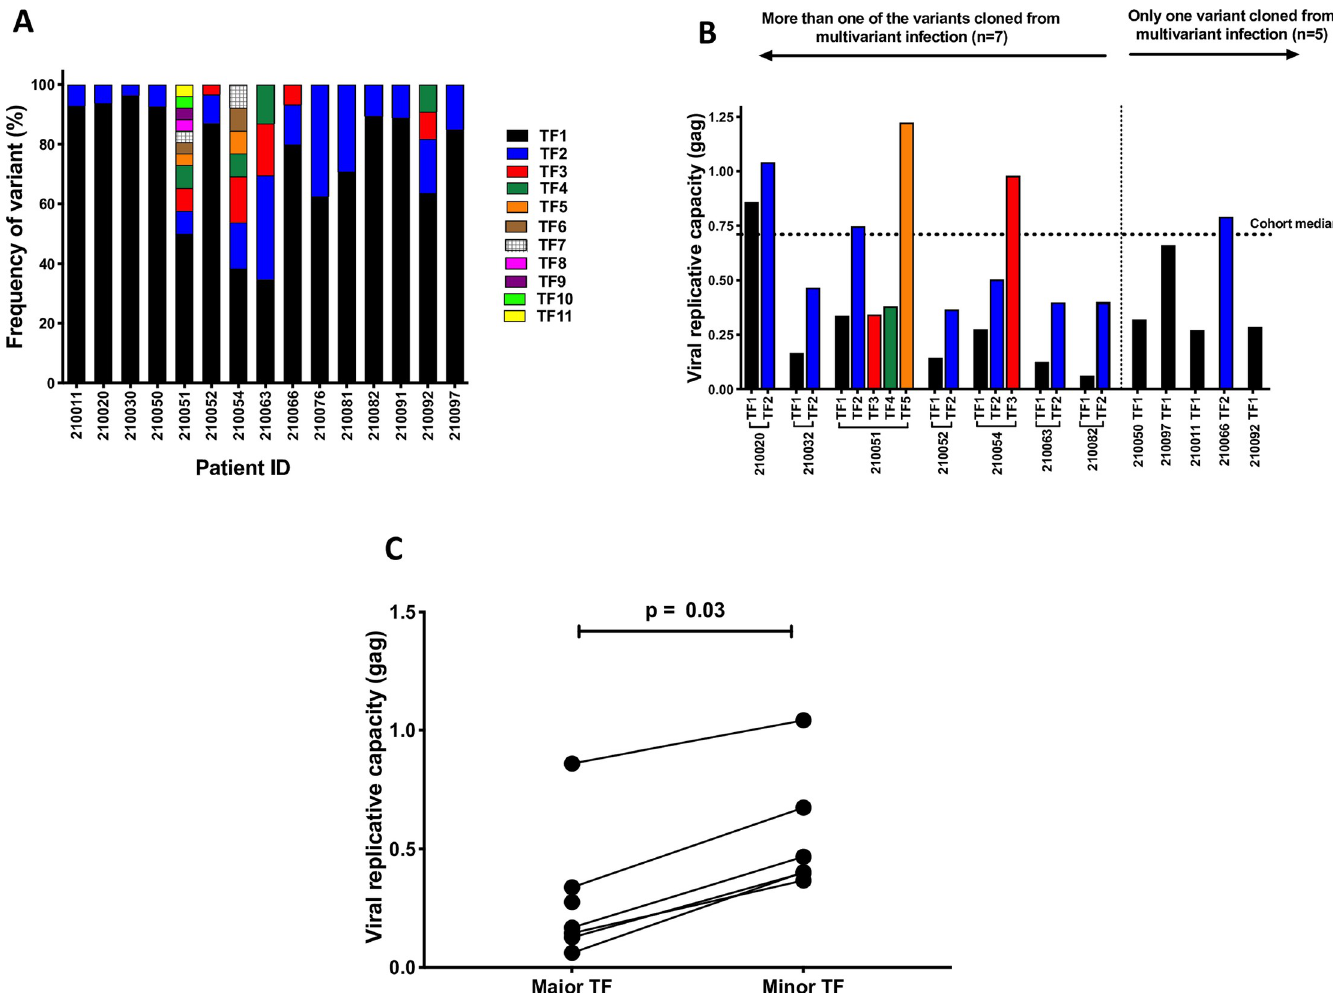
Fig 3. A) Proportion representation of multiple transmitted/founder viruses showing unequal representation of variants, with major variants representing as much as 96% of the virus populations and minor variants representing as low as 3% of the virus population sampled. B) A wide range of replicative capacity of intra patient founder viruses was observed, with no evidence for selection of similar replicative capacity. More than one TF gag variant was cloned and tested in 7 participants and only one variant was tested in 5 participants. The major variant (termed TF1) often displayed lower replicative capacity than the minor variants (TF2 to TF5). C) Matched pairwise comparison between the replicative capacity of the major variant and the mean replicative capacity of the minor variant(s) in the 7 cases where more than one variant had been cloned showing lower replicative capacity in the major variants compared to the minor variant (Wilcoxon matched pairs signed rank, p =